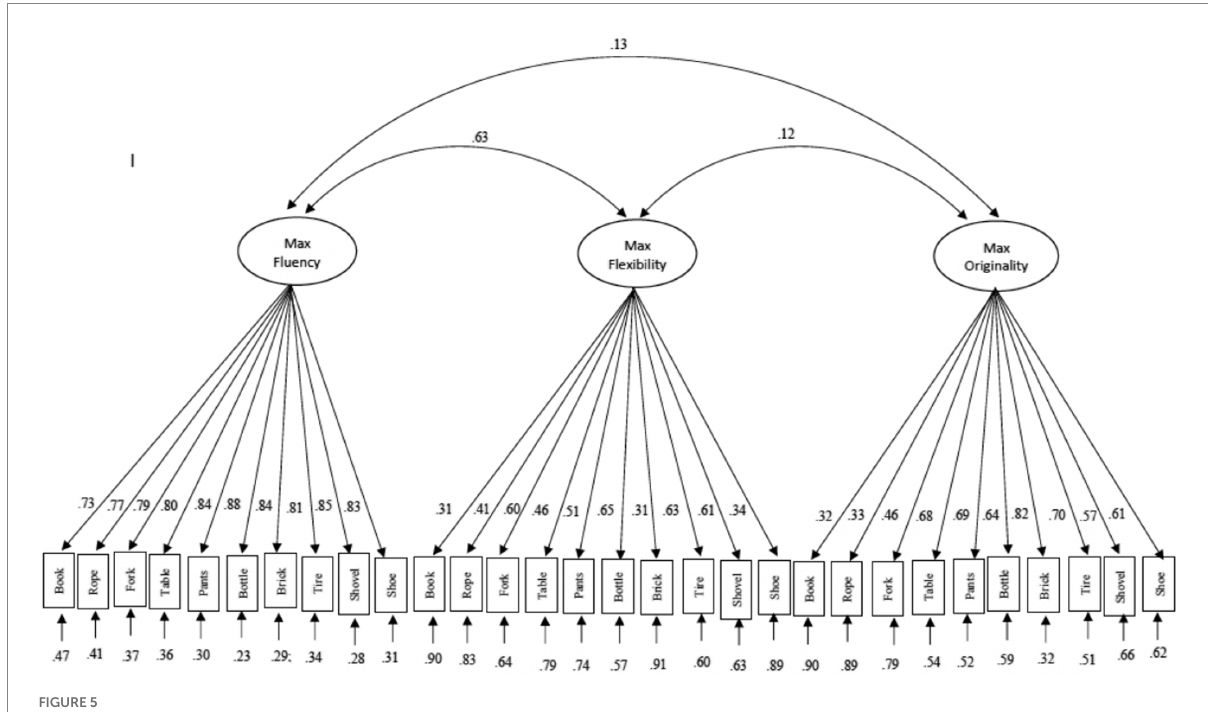
FIGURE 5 Path diagram of maximum flexibility, maximum originality, and fluency scoring.